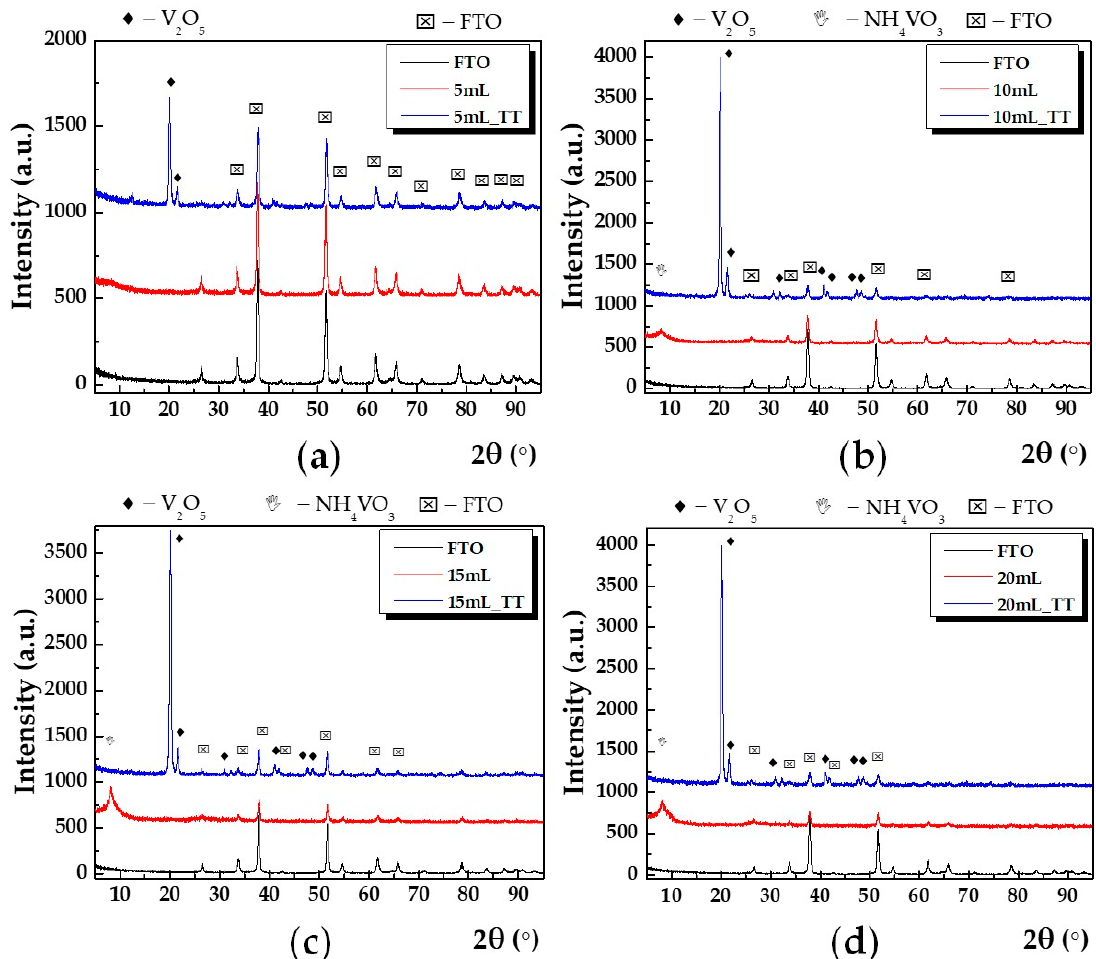
Figure 1. Grazing incidence X-ray di ff raction (GIXRD) patterns for: ( a ) 5 mL before and after annealing; ( b ) 10 mL before and after annealing; ( c ) 15 mL before and after annealing; ( d ) 20 mL before and after annealing; with red and blue line, respectively. In addition, GIXRD pattern corresponding to FTO (Fluorine-doped tin oxide) was added (black line).